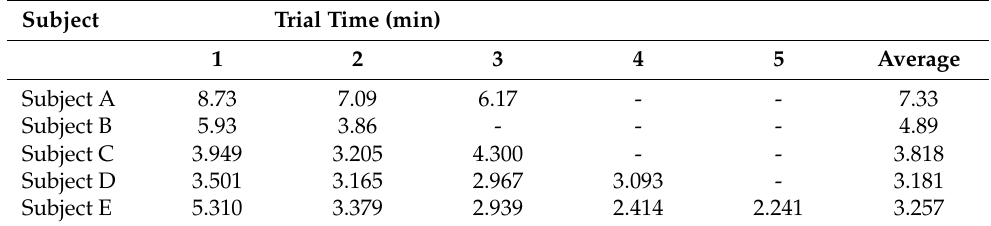
Table 3. Comparative results between subjects.